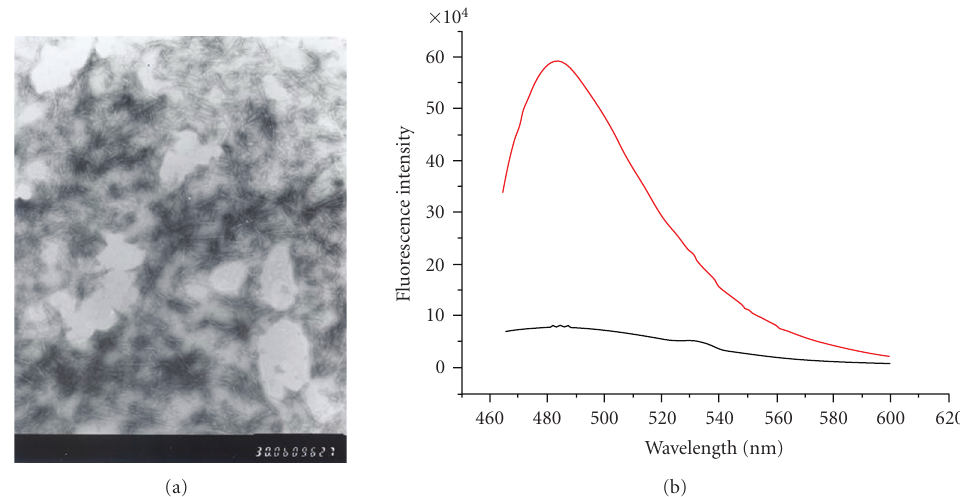
Figure 1: (a) Observation of A β (1 ∼ 40) aggregates by transmission electron microscope (b) Formation of A β (1 ∼ 40) aggregates using Thioflavine T by fluorescence spectroscopy red line: fluorescence intensity of the mixture of 5 μ L solution of A β (1 ∼ 40) aggregates and 500 μ L solution of Thioflavine T (2 μ M); black line: fluorescence intensity of 500 μ L solution of Thioflavine T (2 μ M) only.